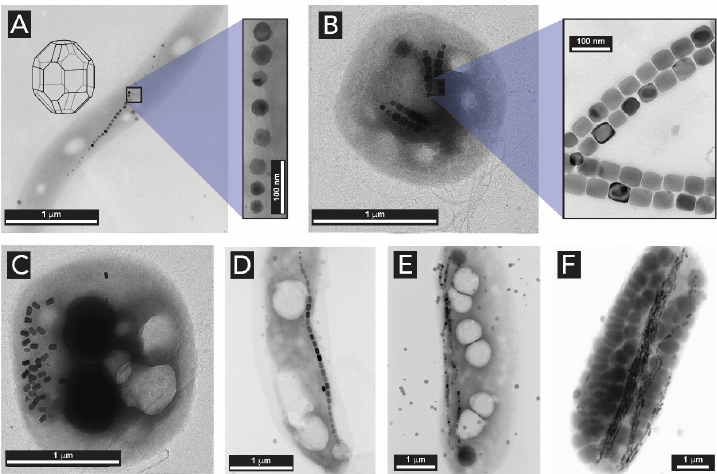
Figure 22. TEM images of different magnetotactic bacteria (Gram-negative type) and magnetosome chains (black dots). ( A ) A spirillum with a single chain of polyhedral magnetosomes. Inset illustrates a model of the particles. ( B ) A coccus with two double chains of slightly elongated prismatic magnetosomes. ( C ) A coccus with clustered, elongated magnetosomes. ( D ) A vibrio with elongated prismatic and cubo octahedral magnetosomes arranged into a single chain. ( E ) A vibrio with two chains, and ( F ) a rod-shaped bacterium with bullet-shaped magnetosomes arranged into several parallel chains. Adapted from [1] with permission from the American Chemical Society.